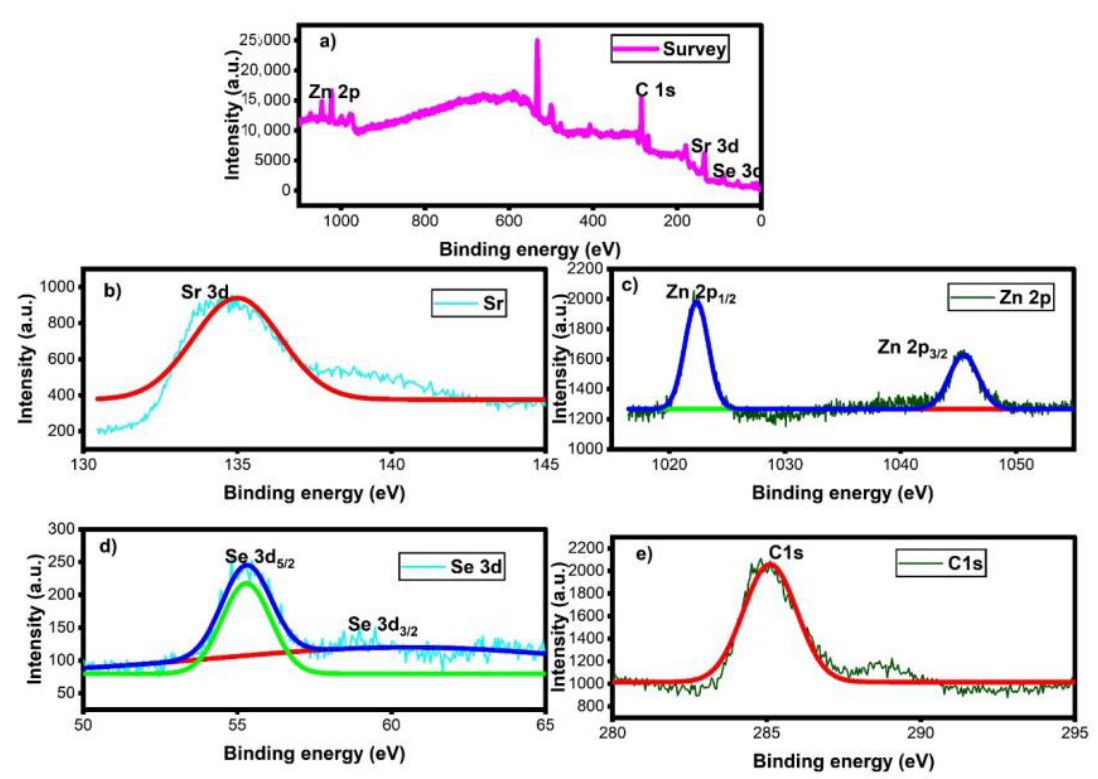
Figure 7. XPS spectra of Sr (0.1)-doped ZnSe nanoparticles; ( a ) wide spectrum, ( b ) Sr-3d spectrum, ( c ) Zn-2p spectrum, ( d ) Se-3d spectrum, and ( e ) C-1s